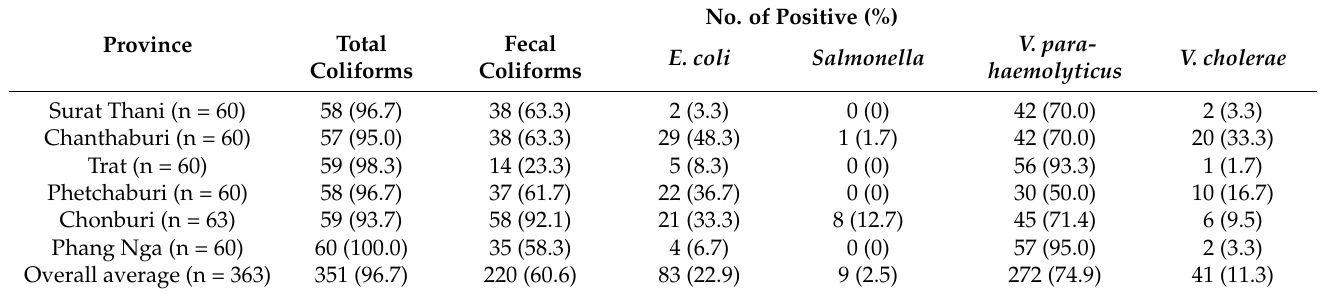
Table 4. Prevalence of total coliforms, fecal coliforms, E. coli , Salmonella , V. parahaemolyticus , and V. cholerae in coastal water samples (n = 363) from oyster production regions in